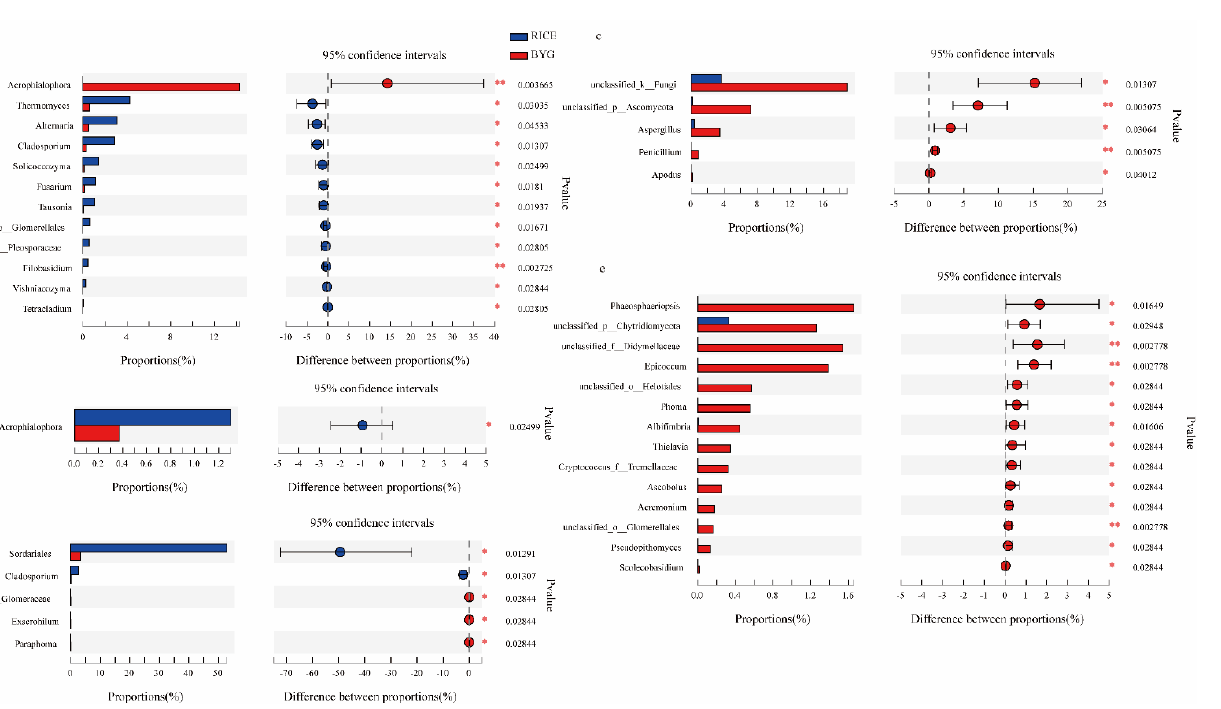
Figure 5. Endophytic fungi were significantly different between rice and barnyardgrass groups at the genus level at BBCH 17 ( a ), 24 ( b ), 37 ( c ), 45 ( d ), and 57 €. At BBCH 24 (Figure 5b), Acrophialophora was significantly enriched in rice roots. At BBCH 37 (Figure 5c), Fungi(k), Ascomycota(p), Aspergillus , Penicillium , and Apodus were much more frequent in barnyardgrass. At BBCH 45 (Figure 5d), Sordariales(o) and